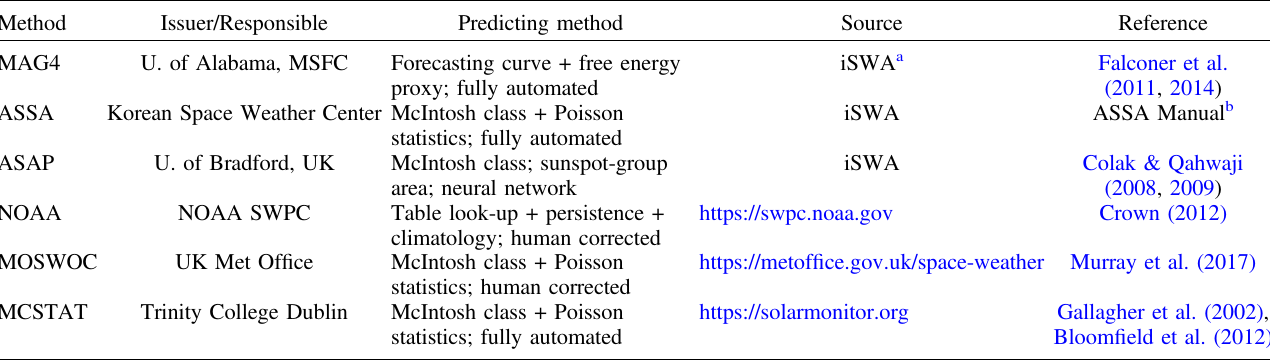
Table 1. Flare Forecasting methods included in the ensemble forecast (members). Name, developer/issuer/responsible institution, details on predictive model, archive or place used to retrieve forecasts, and references for each method are presented.